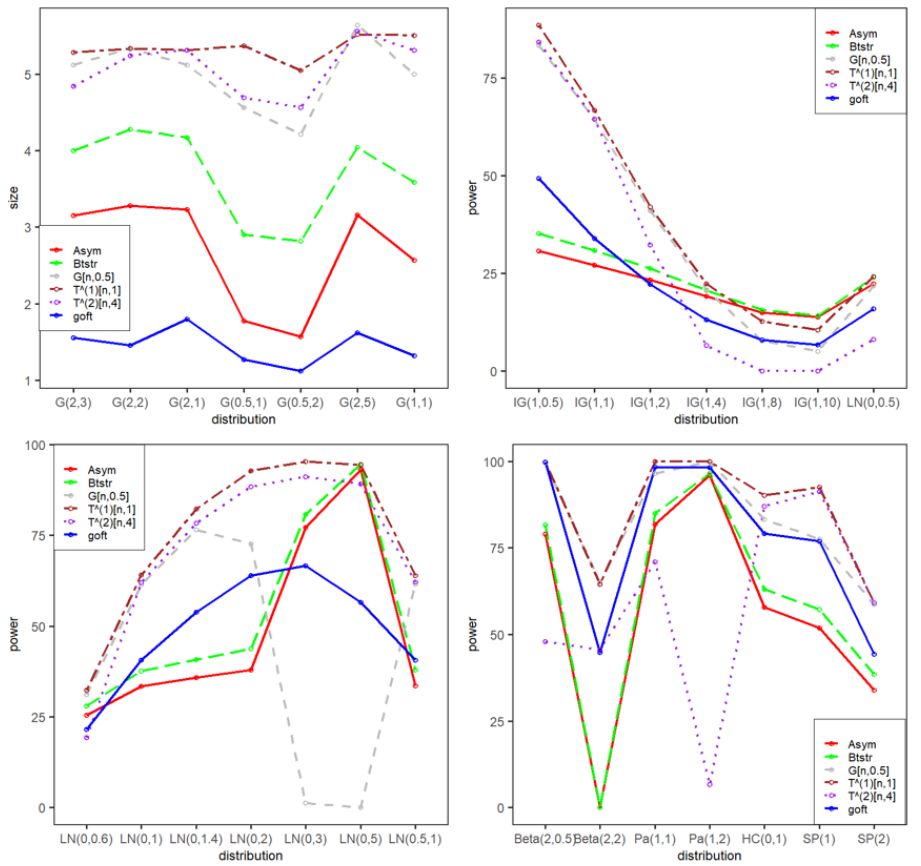
Figure 1. Power curves of the test statistic for 21 alternative distributions, where the null distribution is gamma. The variance M was estimated using the MLE. This figure corresponds to Table 1 in the main text ( n = 50; α =